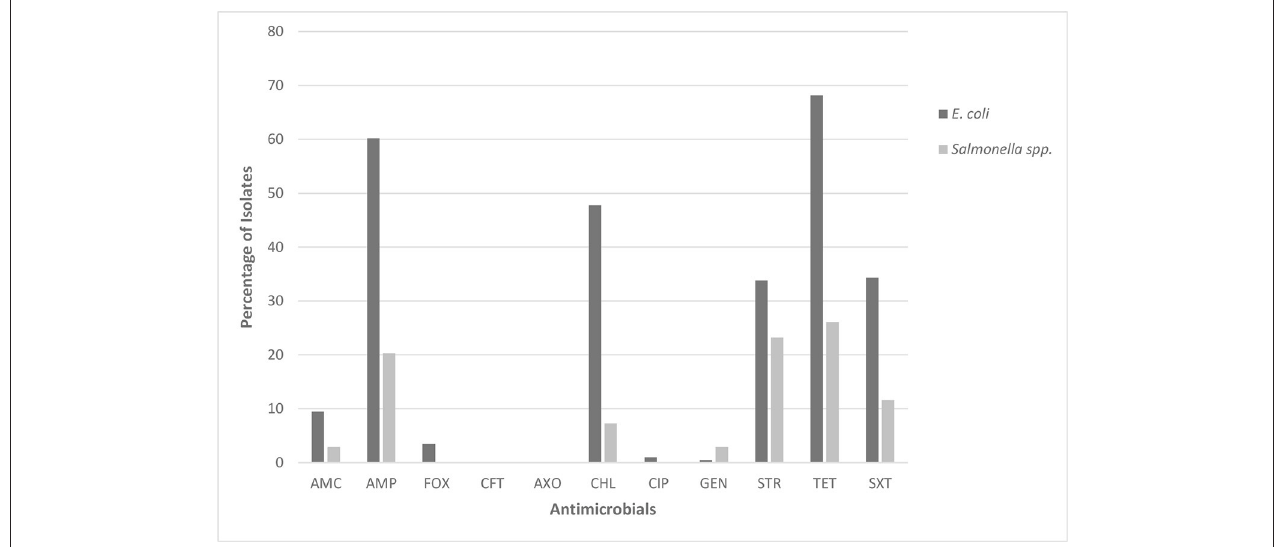
FIGURE 1 | Percentage of E. coli ( n = 201) and Salmonella spp. ( n = 69) isolates showing non-susceptibility to 11 selected antimicrobials. AMC, amoxicillin/clavulanic acid; AMP, ampicillin; FOX, cefoxitin; CFT, ceftiofur; AXO, ceftriaxone; CHL, chloramphenicol; CIP, ciprofloxacin; GEN, gentamicin; STR, streptomycin; TET, tetracycline; SXT,